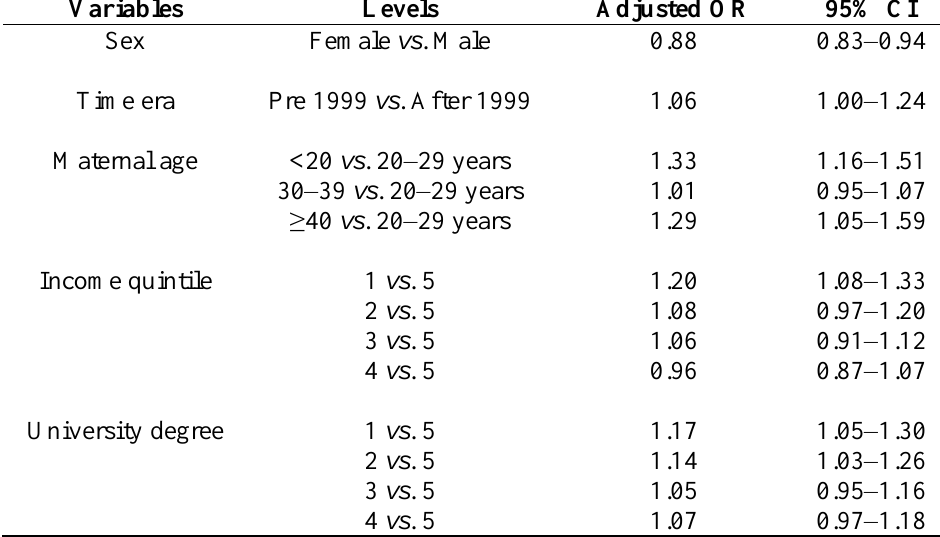
Table 3. Adjusted odds ratios for maternal and infant characteristics, Ontario 1994 